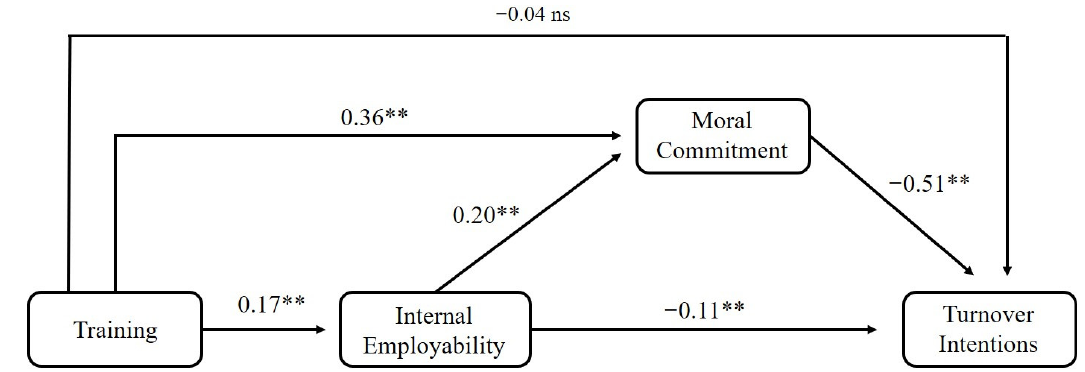
Figure 2. Model 1. Note. ** p < 0.01. Table 5. Indirect Effects of the Model 1.